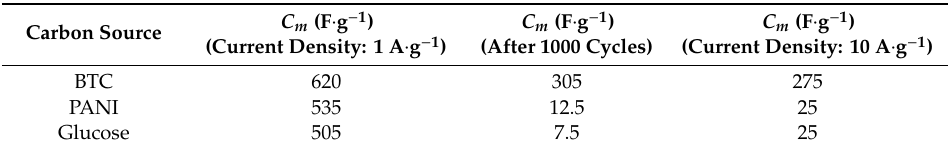
Table 1. Comparison of specific capacitance, rate capability and stability of samples with di ff erent carbon